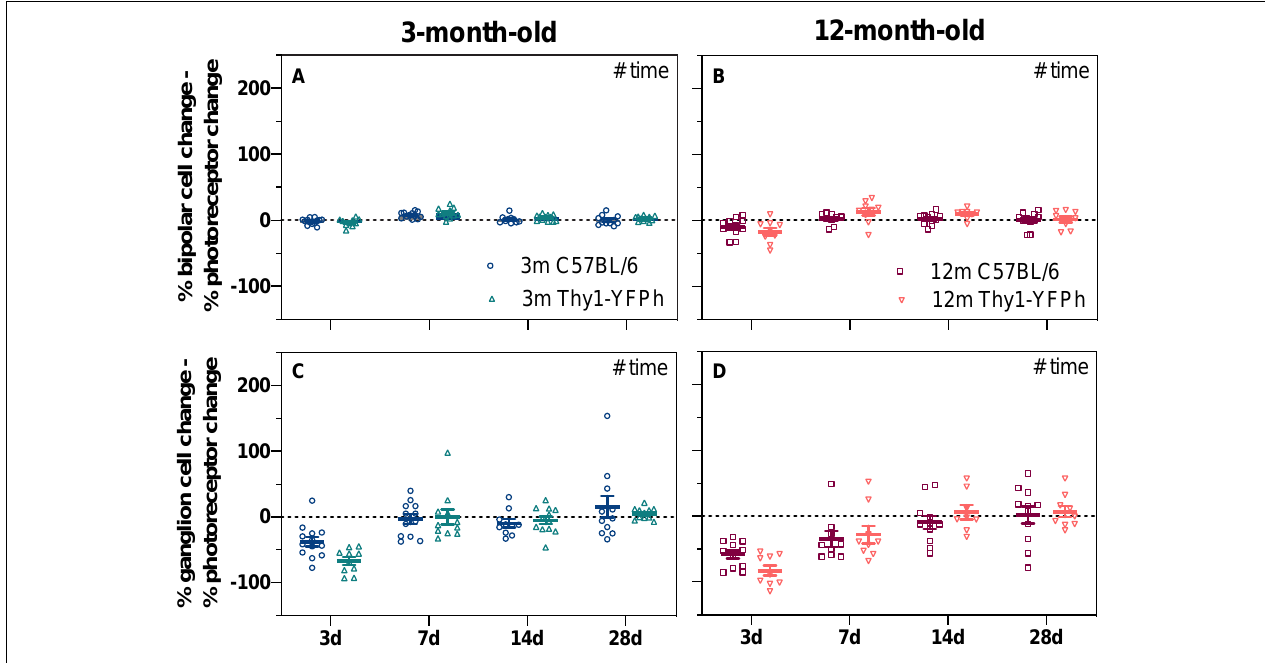
FIGURE 4 | Age-matched strain comparison of bipolar cell and ganglion cell responses expressed relative to their own photoreceptor input. Responses from IOP-treated eyes were expressed relative to their contralateral control eyes (%). (A,B) The % photoreceptor response was subtracted from % bipolar cell response in (A) 3-month-old and (B) 12-month-old mice. This normalizes the bipolar cell response relative to the photoreceptor input. (C,D) The % photoreceptor response was subtracted from % ganglion cell response in (C) 3-month-old and (D) 12-month-old mice. This normalizes the ganglion cell response relative to the photoreceptor input. A resultant negative % difference indicates that ganglion cell function was more affected than expected from photoreceptor input. 3-month-old C57BL/6 mice (blue, 3 days, n = 13; 7 days, n = 12; 14 days, n = 10; 28 days, n = 11); 3-month-old Thy1-YFPh mice (teal, 3 days, n = 10; 7 days, n = 11; 14 days, n = 12; 28 days, n = 11); 12-month-old C57BL/6 mice (red, 3 days, n = 11; 7 days, n = 9; 14 days, n = 11; 28 days, n = 11); 12-month-old Thy1-YFPh mice (orange, 3 days, n = 9; 7 days, n = 9; 14 days, n = 8; 28 days, n = 9). Error bars, SEM; #, two-way ANOVA p <